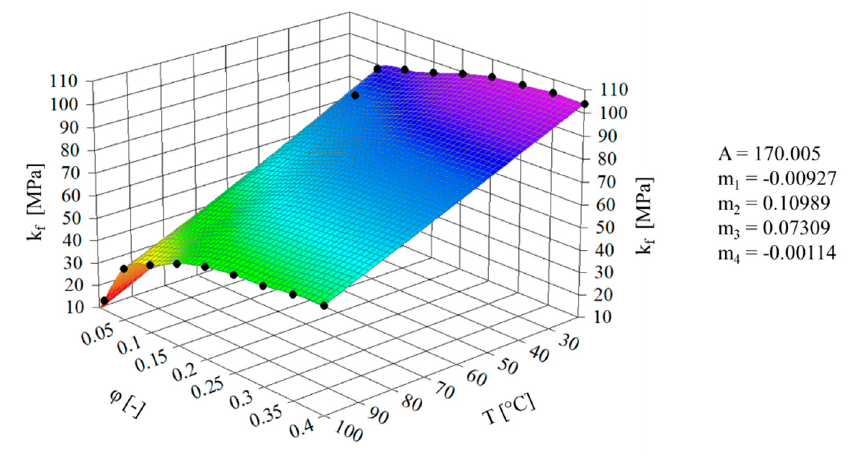
Figure 9. Flow stress depending on plastic strain and temperature for the material PP in the solid state.